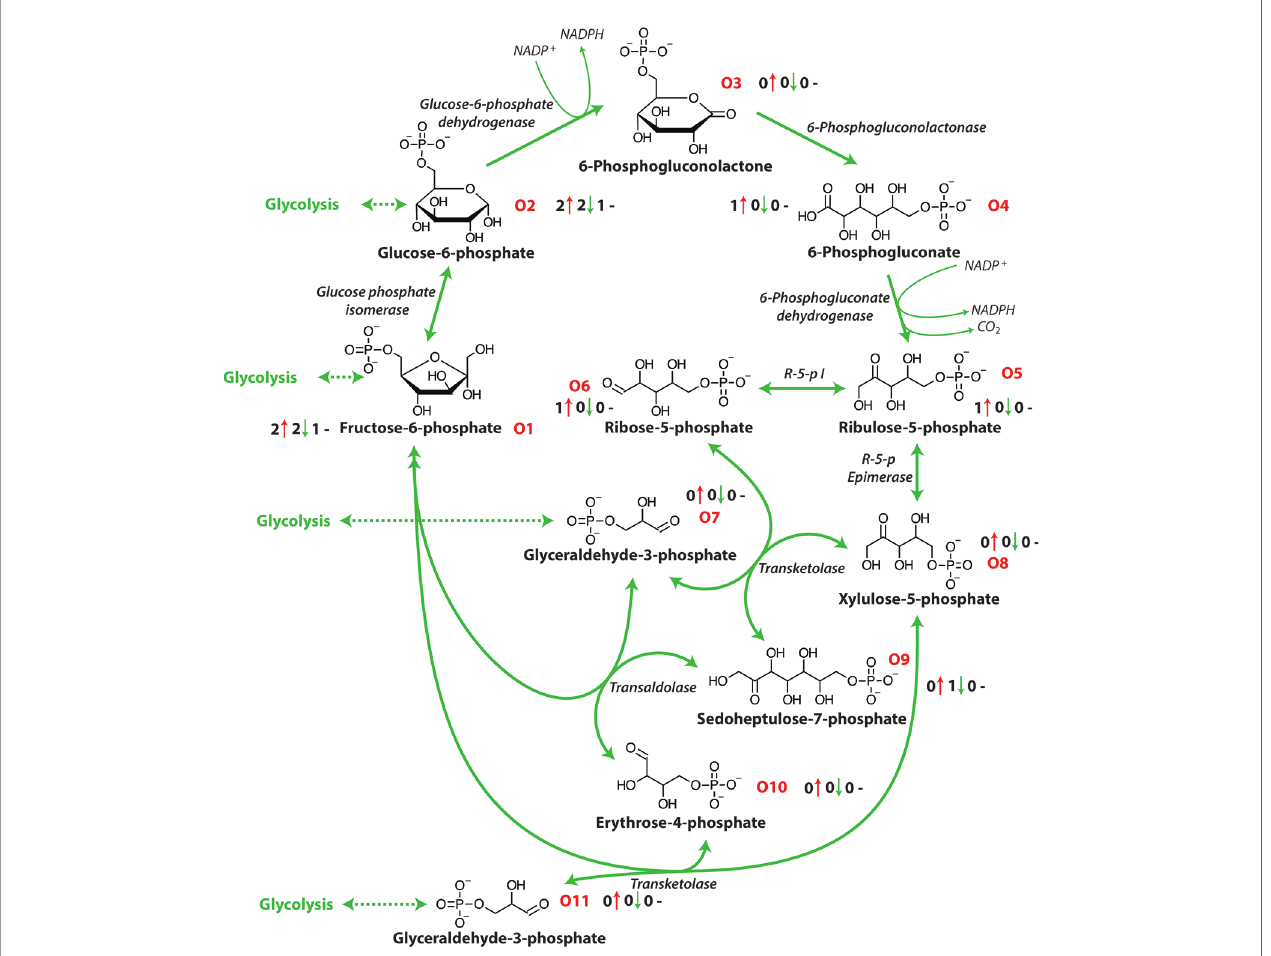
FIGURE 2 | The oxidative pentose phosphate pathway. NADPH, nicotinamide adenine dinucleotide phosphate (reduced); R-5-p I, ribose-5-phosphate isomerase; R-5-p Epimerase, ribulose-5-phosphate epimerase. O1-O10 represent each metabolite of the OPP pathway and the number before the red arrows indicate the number of papers that report an increase in abundance, the number before the green arrows indicates the number of papers that report a decrease in abundance and the number before the black dashes indicates the number of papers that report no change in